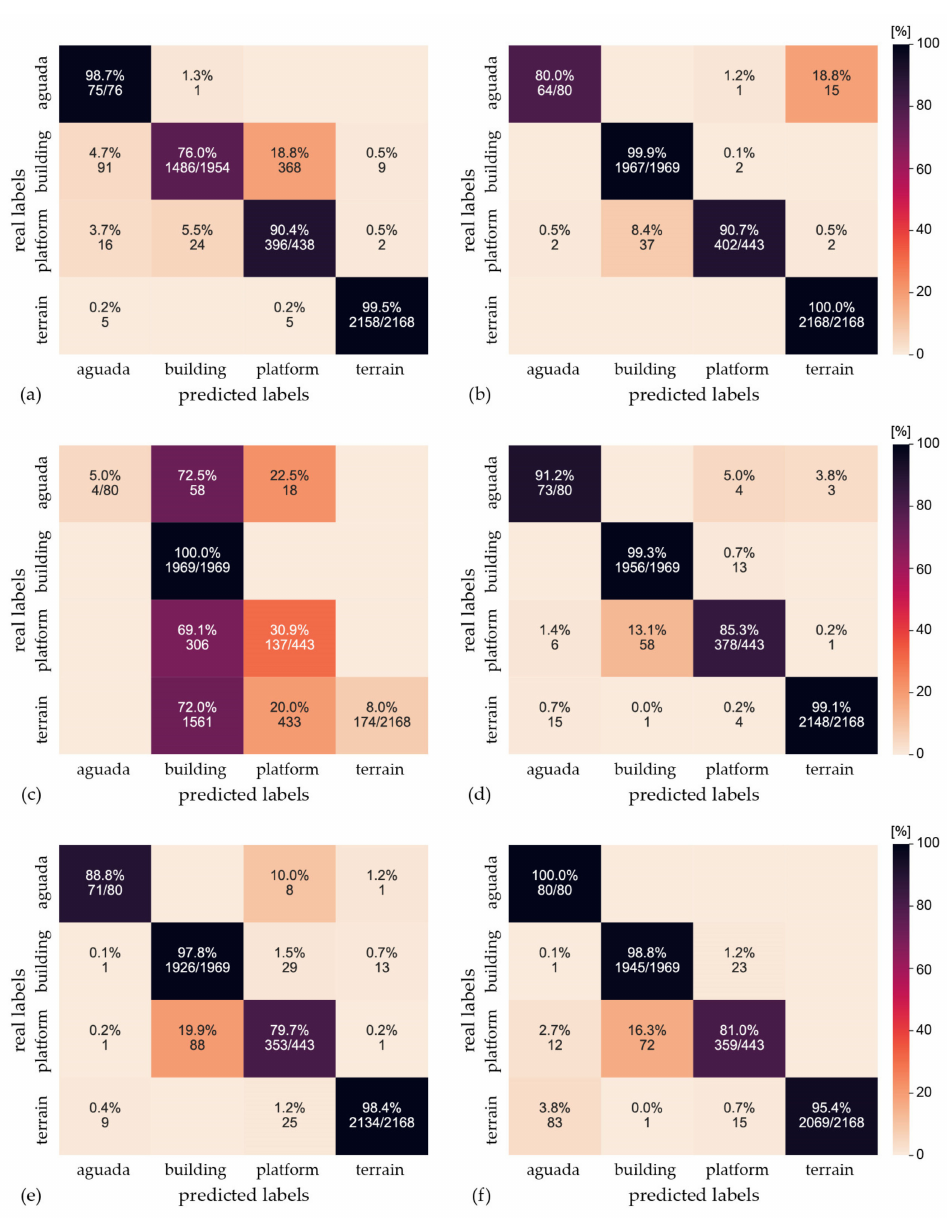
Figure 11. Confusion matrices for six selected scenarios. ( a ) VAT-HS visualization and image samples with 15-pixels edge bu ff er, with Keras data augmentation, 5 frozen layers; ( b ) VAT-HS channels with 2-pixels edge bu ff er, no data augmentation, 3 frozen layers; ( c ) local dominance (LD) with 2-pixels edge bu ff er, no data augmentation, 3 frozen layers, added as an example of a low performing model; ( d ) VAT-HS with 2-pixels edge bu ff er, no data augmentation, 5 frozen layers, ( e ) Red relief image map (RRIM) with 2-pixels edge bu ff er, no data augmentation, 5 frozen layers; and finally, ( f ) VAT-HS channels with 2-pixels edge bu ff er, with Keras data augmentation and 5 frozen